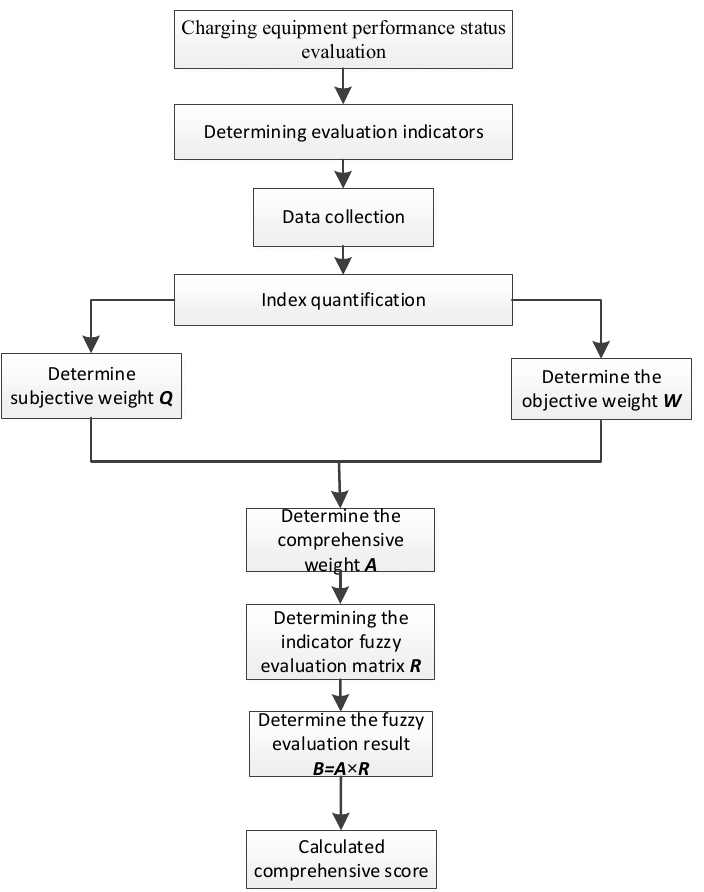
Figure 1. Charging infrastructure evaluation flow chart.